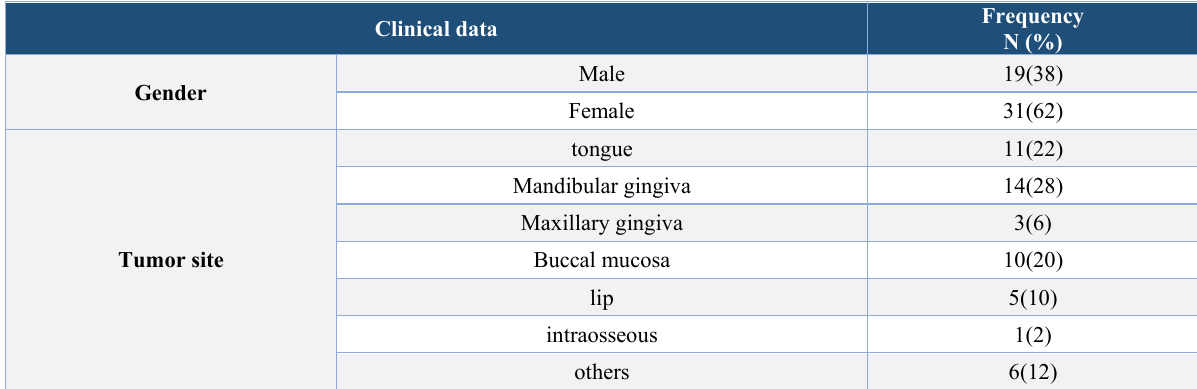
Table 1. Demographic data of OSCC samples